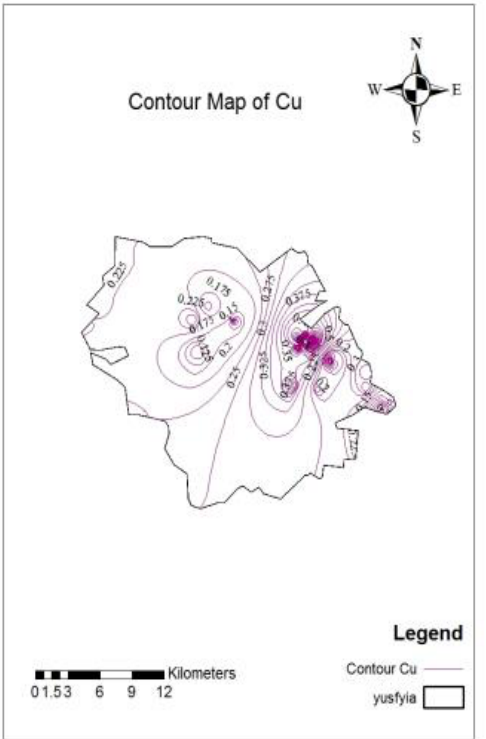
Fig.16: The interpolation and contour line of Cu map in ppm.